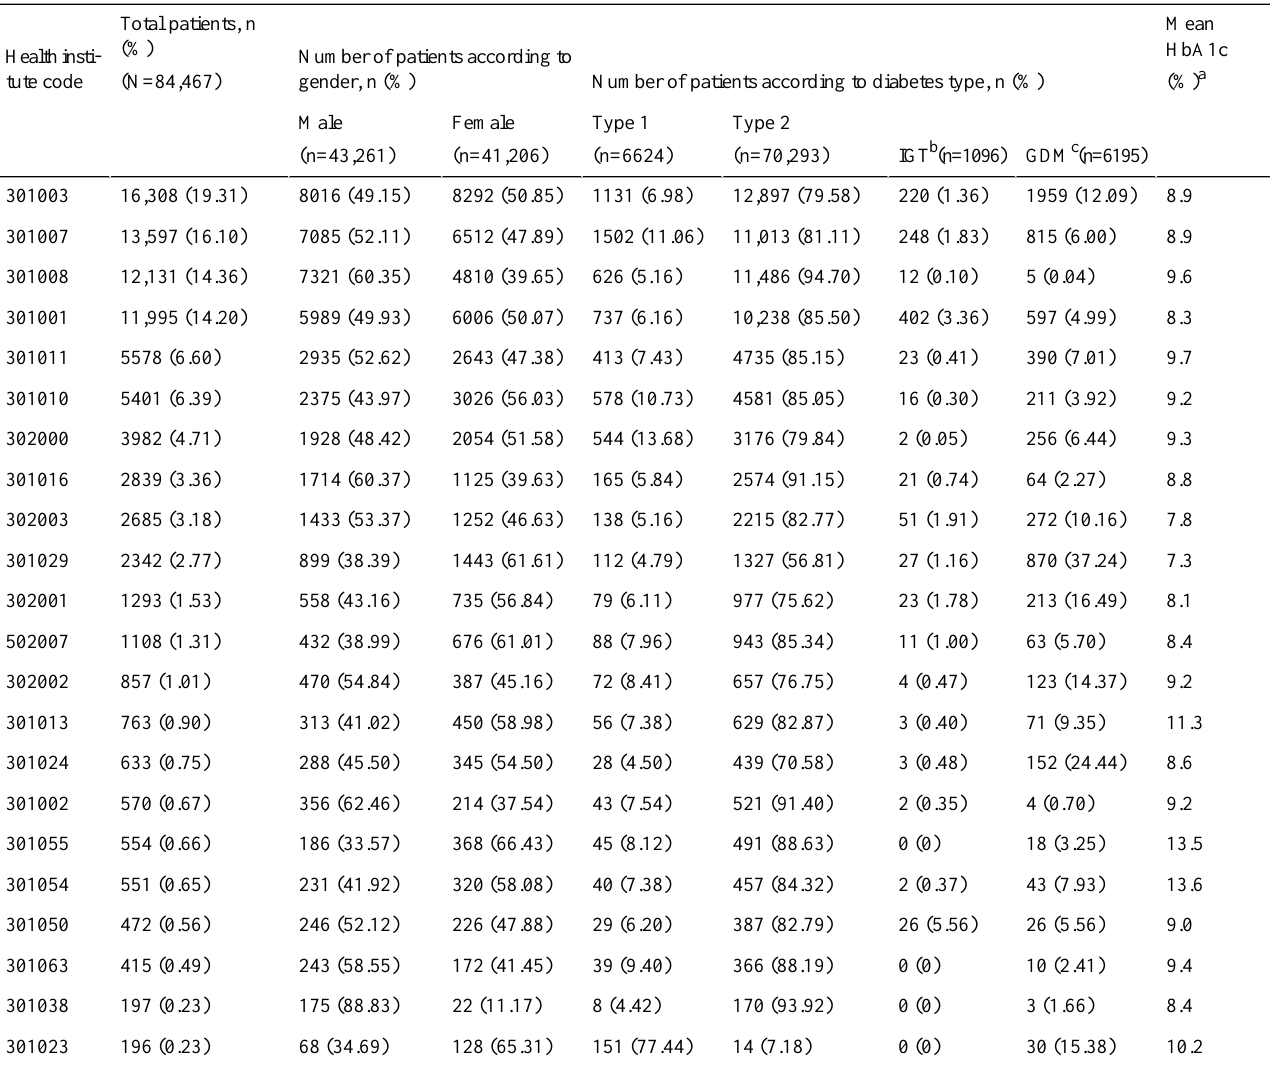
Table 1. Number of patients and frequency distribution from 22 randomly selected health care institutes according to gender, diabetes type, and mean HbA1c values.